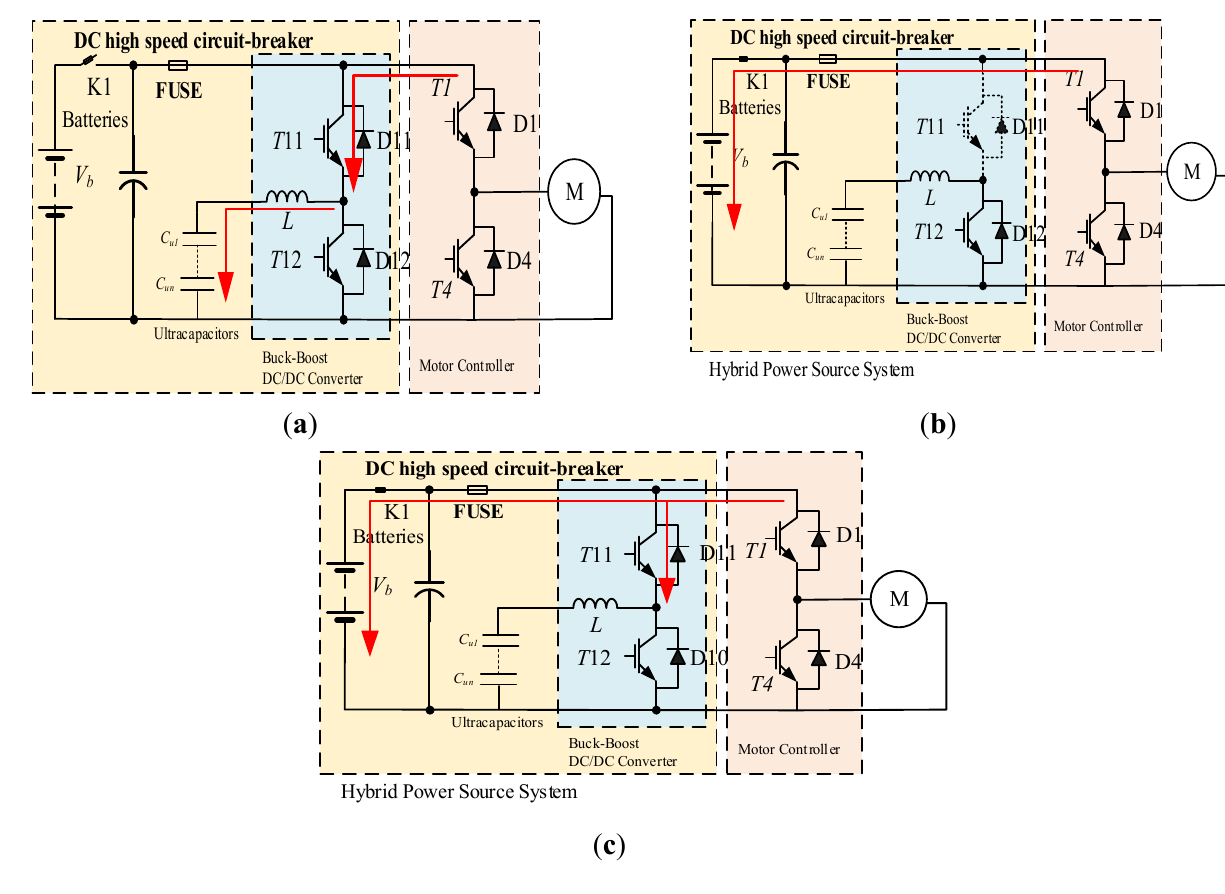
is charged with priority; ( b ) the batteries are discharged; ( c ) the batteries and UCs are charged simultaneously when an emergent braking operation is